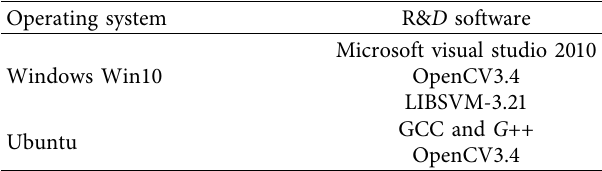
Table 1: Experimental hardware and software environment.